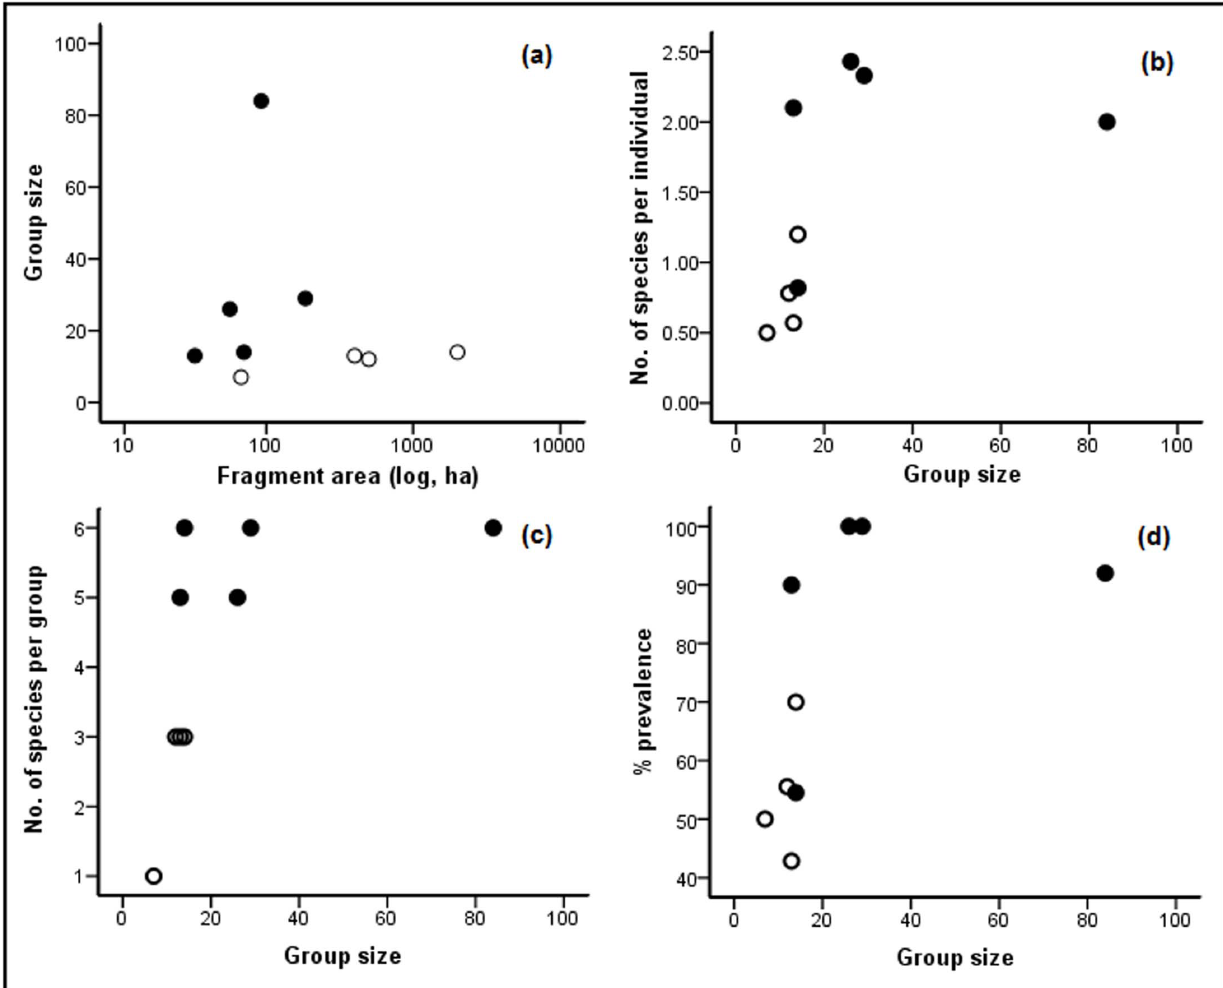
Figure 1. The relationship between group size in the lion-tailed macaque and attributes of gastrointestinal parasites; (a) group size and fragment area; (b) the number of parasitic taxa per individual and group size; (c) the number of parasitic taxa per group and group size; and (d) group size and the overall parasite prevalence in groups in nine forest fragments ( N ) with or (O) without human settlements.